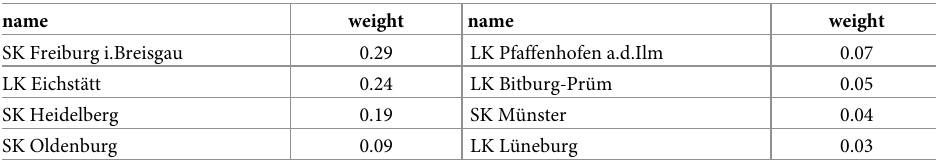
Table 1. Control counties and their weights for Fig